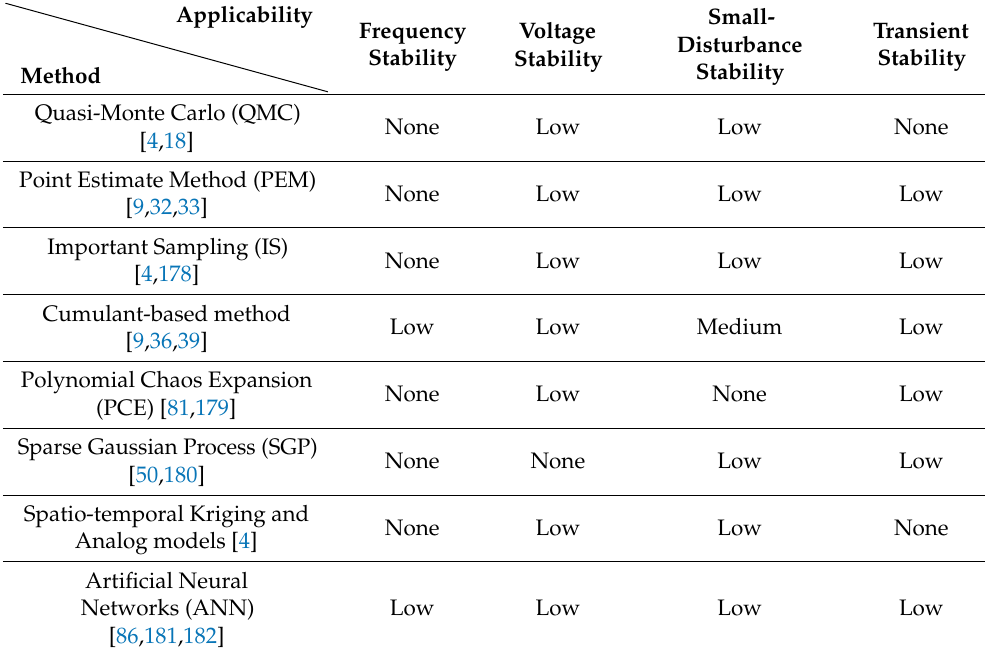
Table 3. The application of accurate and efficient uncertainty modelling techniques in different power system stability